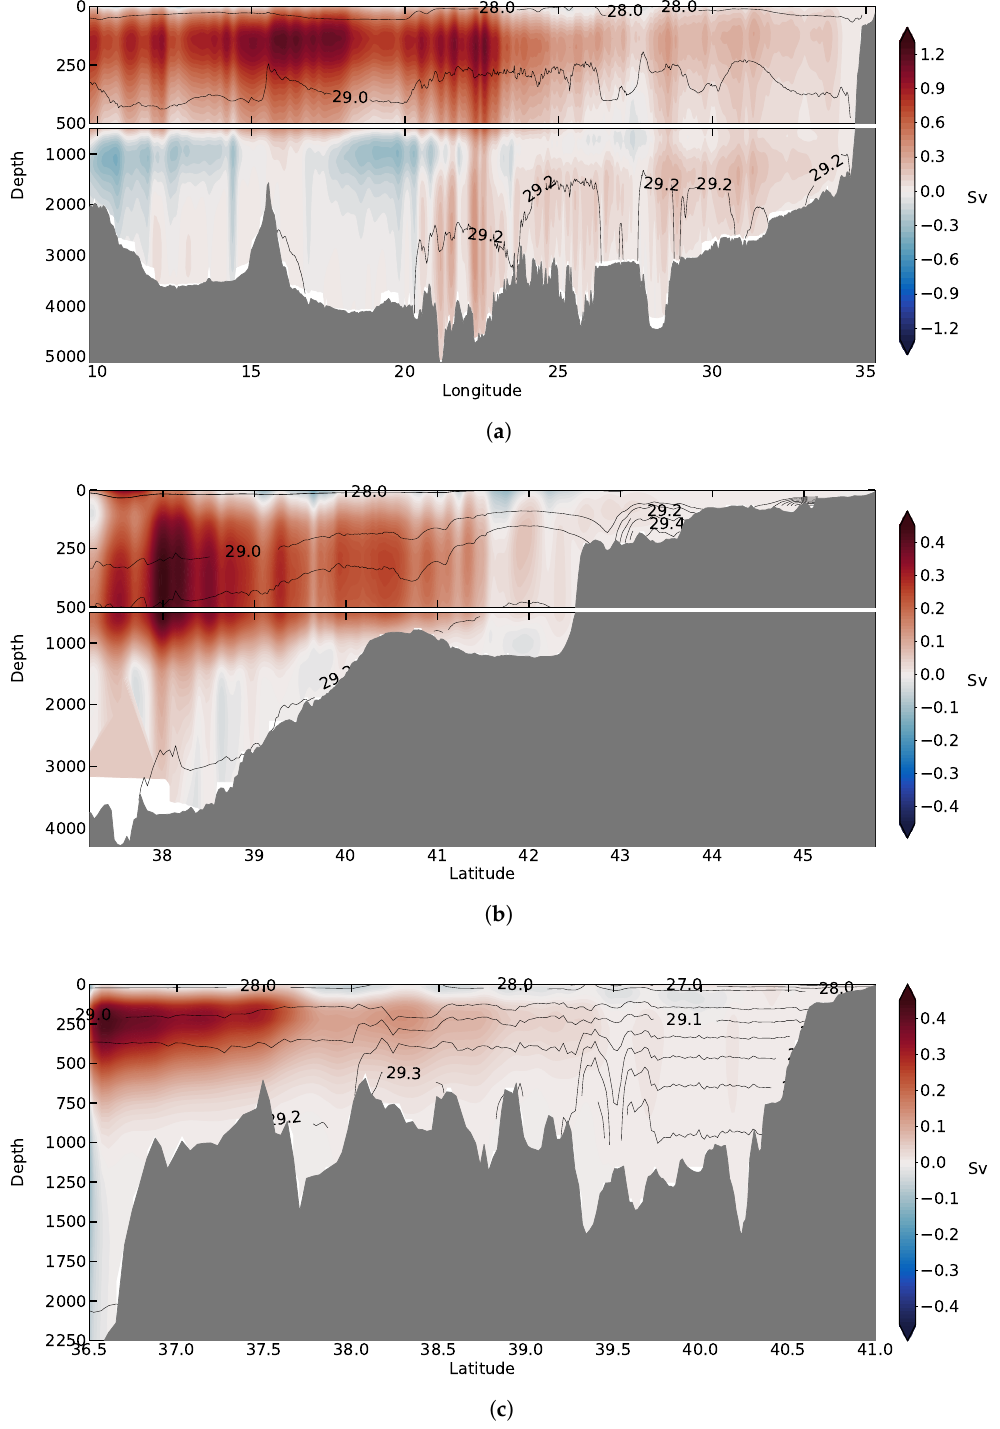
Figure 13. Zonal and meridional overturning streamfunctions for the period 1985–2014. ( a ) Zonal streamfunction for the Eastern Mediterranean (excluding the Black Sea), ( b ) Meridional streamfunction for the Adriatic Sea, and ( c ) Meridional streamfunction for the Aegean Sea. Black contours indicate potential density along the midsection of the domain (see Figure